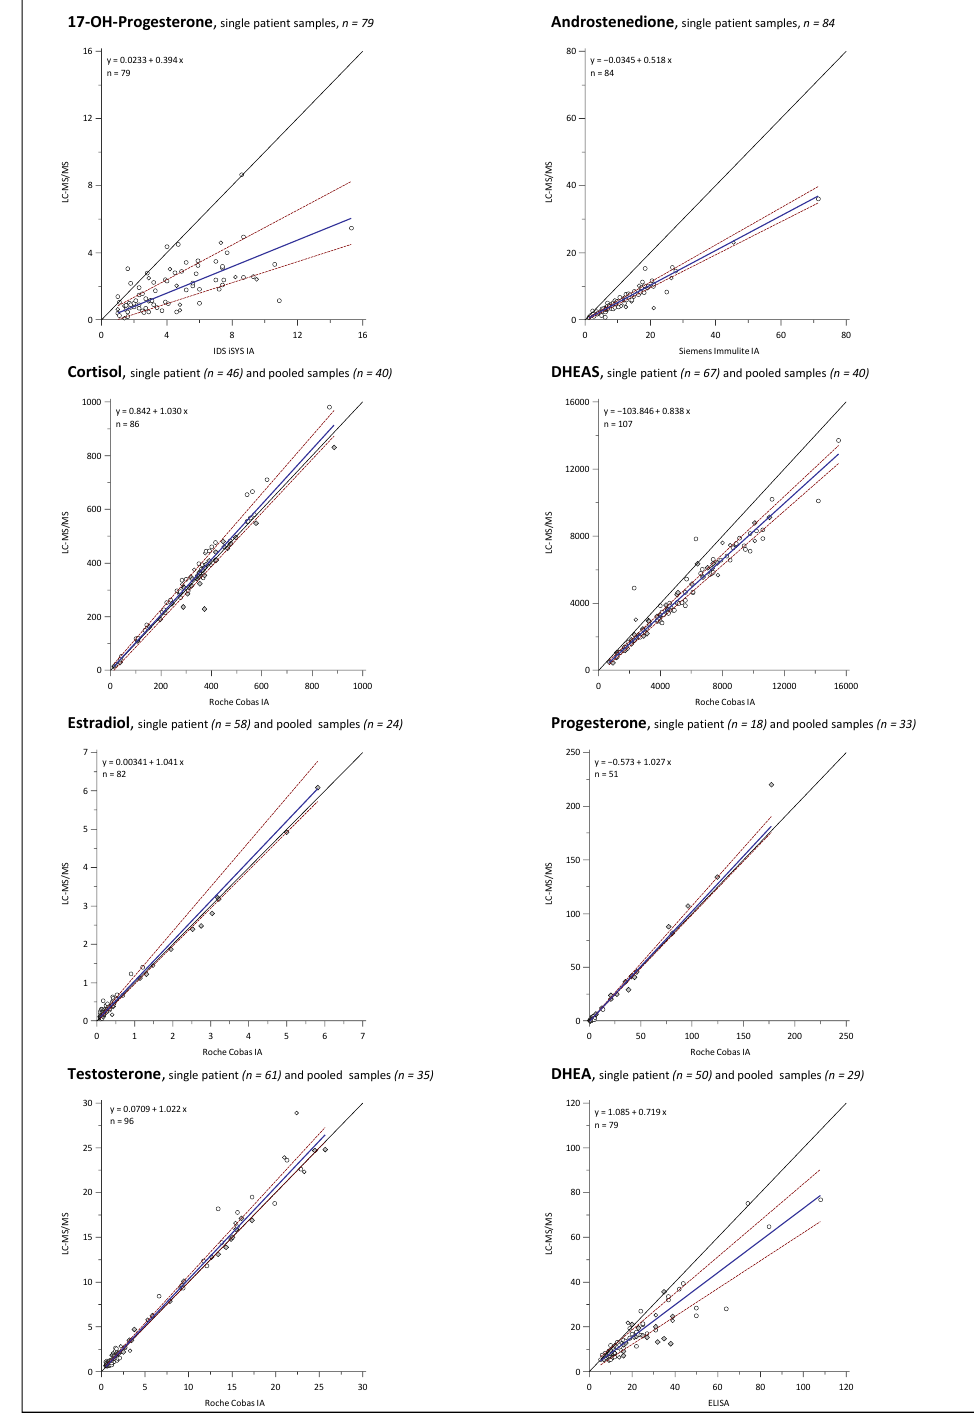
Figure 4. Passing Bablok comparison of the LC-MS/MS method ( y -axis) and in-house immunoassays (IA, x -axis). All results are plotted in nmol/L. Results from patient serum samples are illustrated as circles, from pooled serum samples as squares. Regression line is depicted in blue, 95% CI as dashed lines in red, and line of equality ( x = y ) in black.